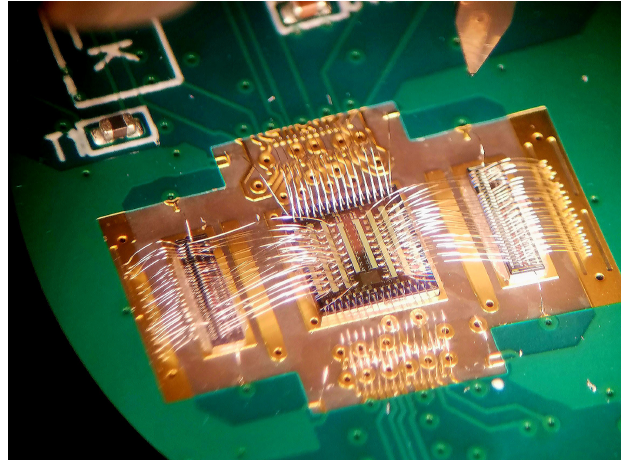
Figure 15. In the middle, the readout ASIC with an array of QC. On both sides, strips of various flavors of SPAD under study during fabrication process